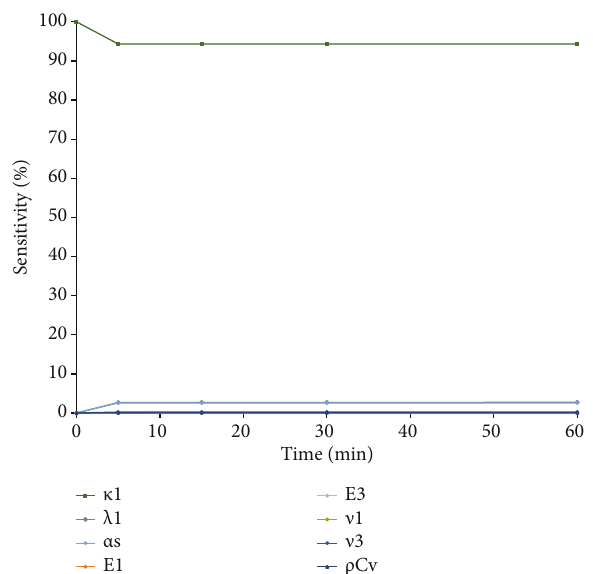
Figure 9: Sensitivity ranking for the transient leak-o ff velocity (m/s) for time interval t = ½ 0, 60 (cid:2) (min).